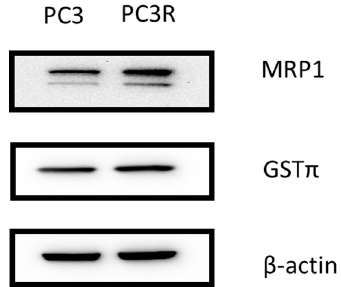
Figure 3. The protein expression of multidrug resistance associated protein 1 (MRP1) and glutathione-S-transferase (GST π ) in docetaxel-resistant (PC3R) and PC3 human prostate cancer cells. Results are representative of three experiments.